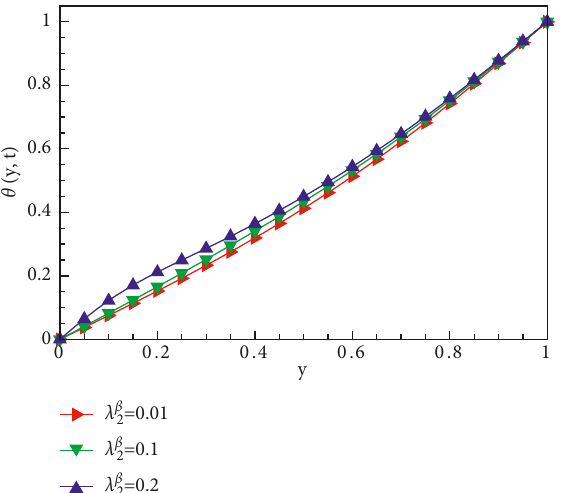
Figure 8: Influence of λ β